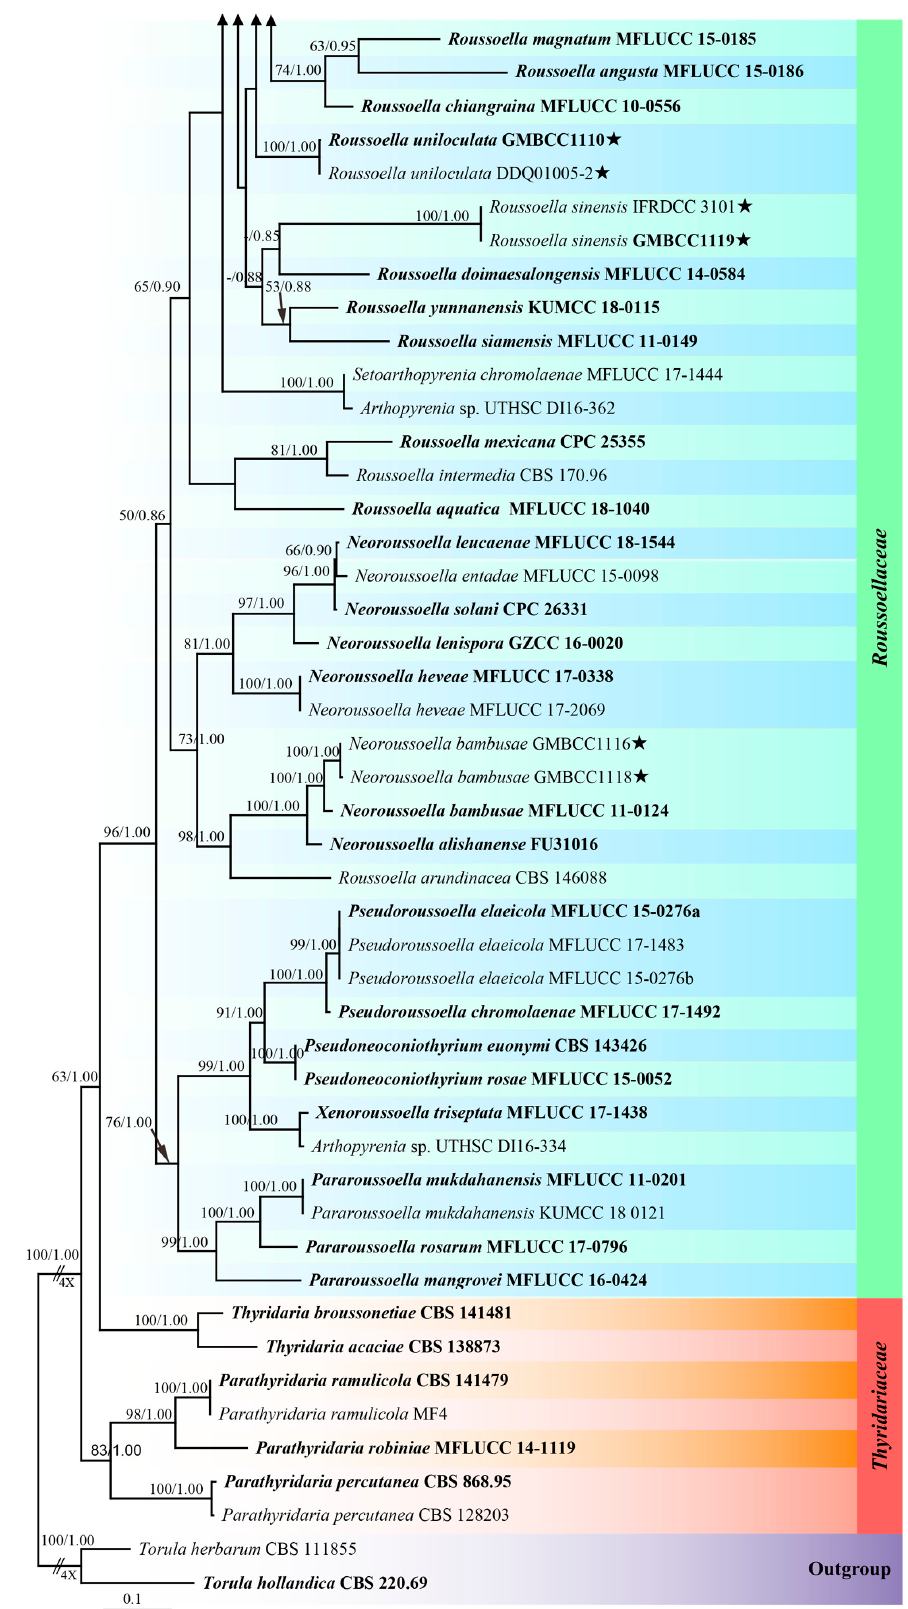
Figure 1. Phylogenetic tree from the best scoring of the RAxML analysis based on combined ITS, LSU, rpb2 and tef1 loci is rooted to Torula herbarum (CBS 111855) and T. hollandica (CBS 220.69).